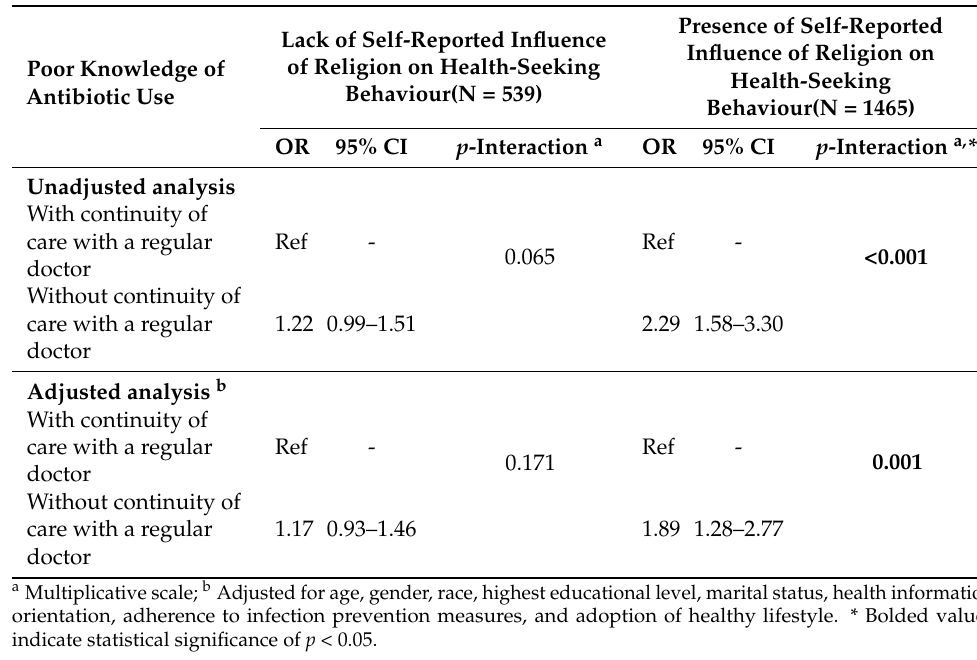
Table 5. Association between poor knowledge of antibiotic use and continuity of care with a regular doctor, according to self-reported influence of religion on health-seeking behaviour (N = 2004).